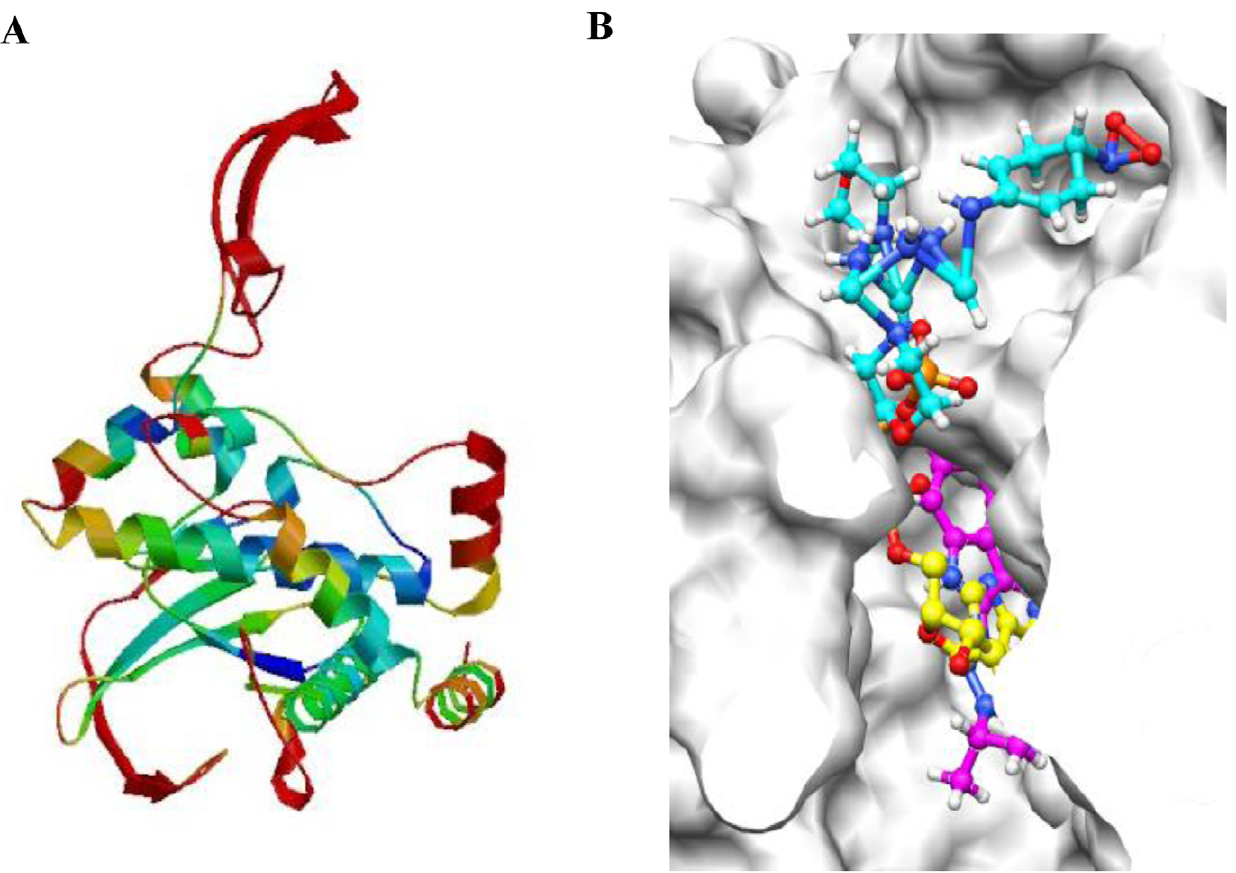
Figure 7. Three-dimensional model of mTOR and docking simulation between mTOR and PP242 and MHY1485. A three-dimensional model of mTOR (NCBI GI number: 4826730) was built using SWISS-MODEL program (A). Homologue structural template used was 1E8X (18% sequence identity and 6.9E-44 e-value). The Z-score of the predicted model was 2 4.8. We checked the quality of each residue on the mTOR structure model. The internal region, which bound ATP and target compounds, was more reliable (blue) than the external region (red) of mTOR. The estimated residue error was visualized using a color gradient from blue (more reliable regions) to red (potentially unreliable regions, estimated error above 3.5 A˚). B shows the docking simulation between mTOR and PP242 and MHY1485. The magenta compound is PP242, which was used as a control compound. The cyan compound is MHY1485, and the yellow compound is ATP. The binding energies of the compounds were 2 7.28 kcal/mol (PP242) and 2 7.55 kcal/mol (MHY1485).